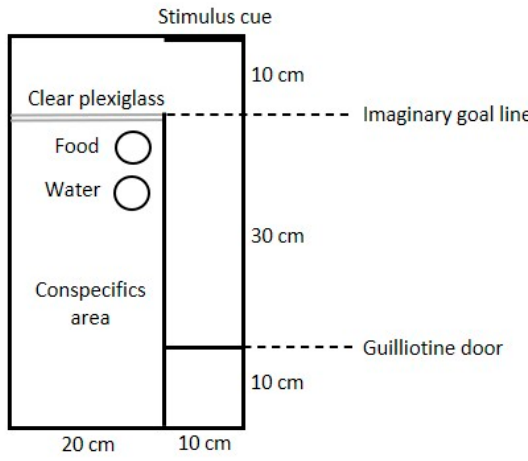
Figure 1. Arena used for 1-week-old chicks to measure cognitive judgement bias.